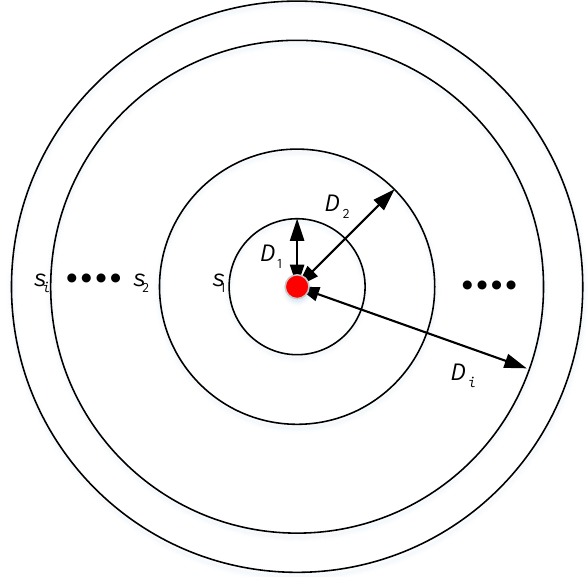
Figure 1. The illustration of the ranges from sensors to a target.